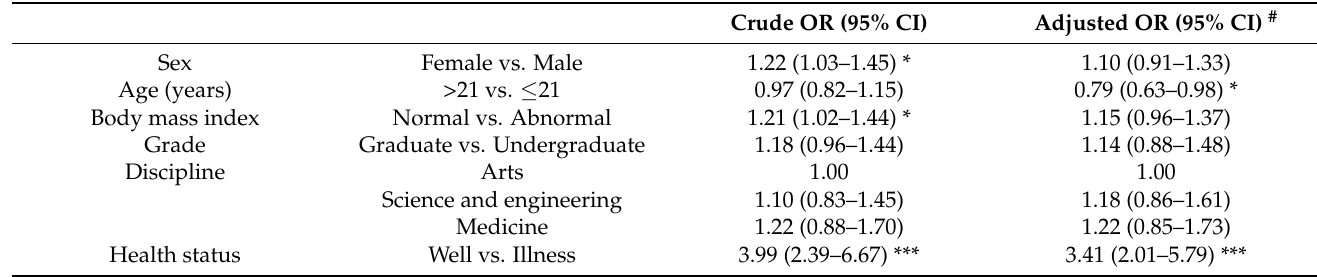
Table 2. Odds ratio (95%CI) of college student happiness for personal factors ( n =